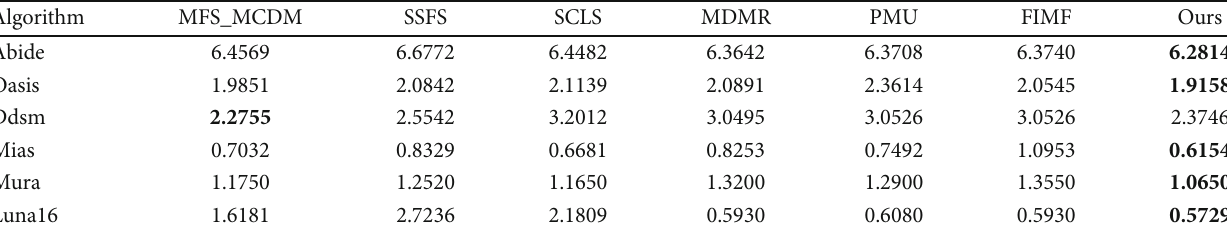
Table 6: Display of optimal experimental results under index coverage.